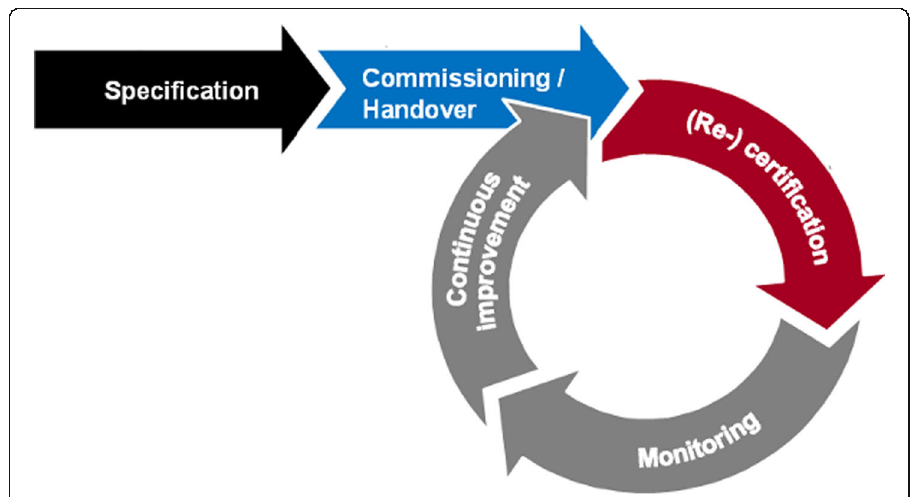
Fig. 3 eu.bac methodology for auditing and certifying building management systems based on the EN 15232 standard (Engvang & Jradi,